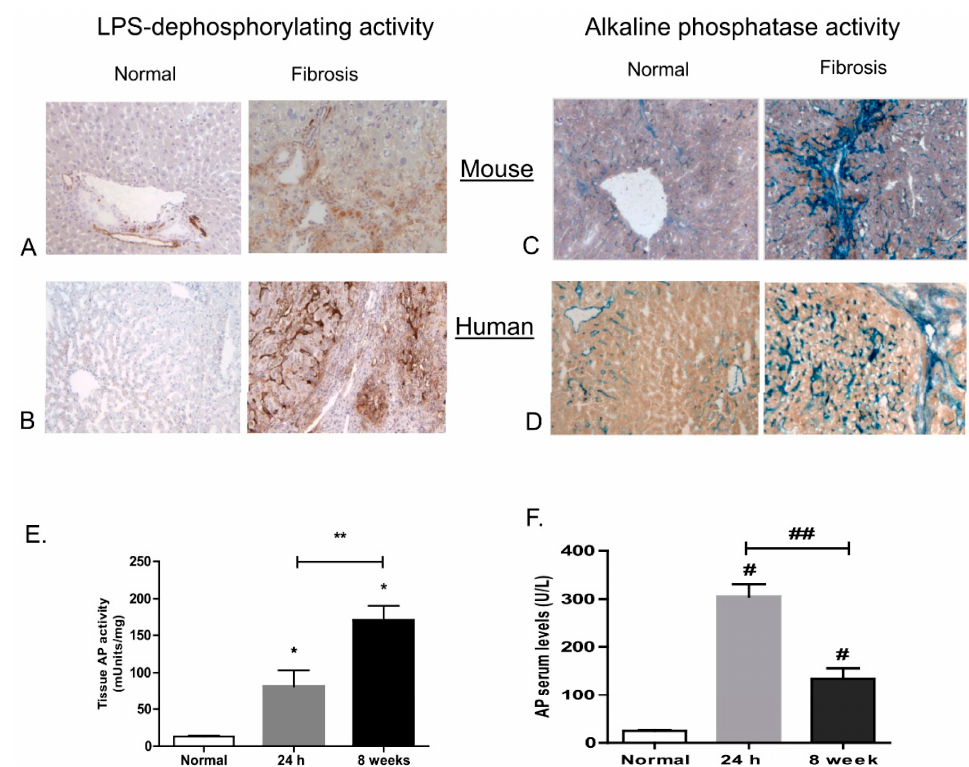
Figure 3. LPS-dephosphorylating ( A , B ) and alkaline phosphatase (AP) activity ( C , D ) in normal and fibrotic livers of mouse and man. Representative pictures of LPS-dephosphorylating activity in mouse ( A ) and human liver tissue ( B ). Brown staining represents sites of enzymatic phosphate release at pH 7.6 LPS from E. coli as substrate (blue is haematoxylin). ( C , D ) AP activity in mouse and human livers, respectively. Blue staining represents phosphatase activity using the substrate Naphthol-ASMX-phosphate at pH 9.8. ( E , F ) Quantification of AP activity in liver tissue ( E ) and in serum ( F ), at t = 24 h and t = 8 weeks of the CCl 4 administration protocol. Note the LPS-dephosphorylating activity in hepatocytes and hepatic arteries and the increase in fibrotic livers relative to normal, in both mouse and human tissue. Abbreviations: ha = hepatic arterioles, bd = bile duct, pv = portal vein, hep = hepatocytes. * = p < 0.05 compared with normal, ** = p < 0.05 24 h vs. 8 weeks CCl 4 , # = p < 0.01 compared with normal. ## p < 0.01 24 h vs. 8 weeks CCl 4 .